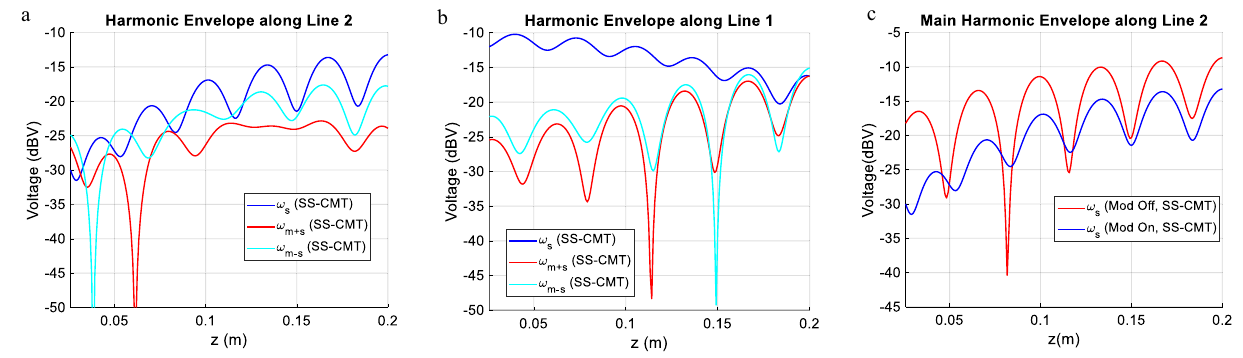
Figure 6. The evolution of the main three harmonics envelopes along the ( a ) line 2 and ( b ) line 1. ( c ) Comparing the envelope of the main harmonic in line 2 for the modulated and unmodulated structure.